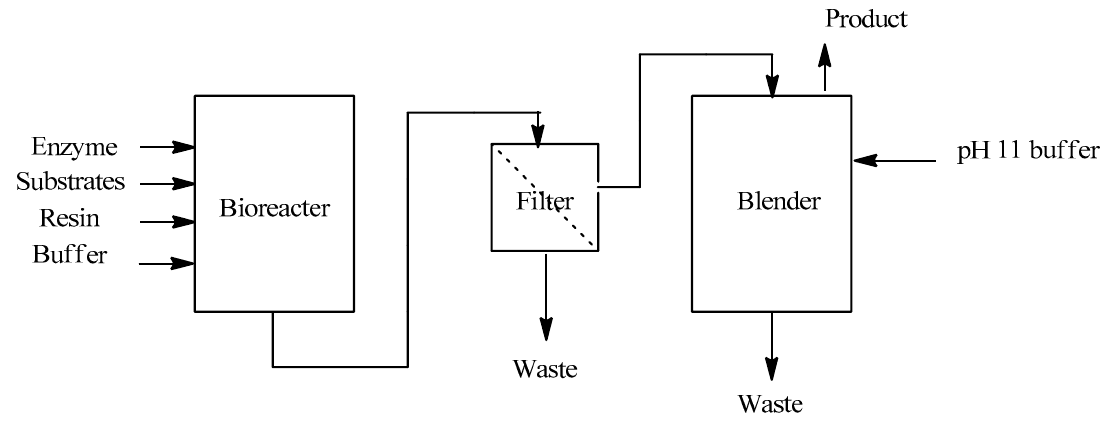
Figure 2. Overview of the biocatalytic transamination process.